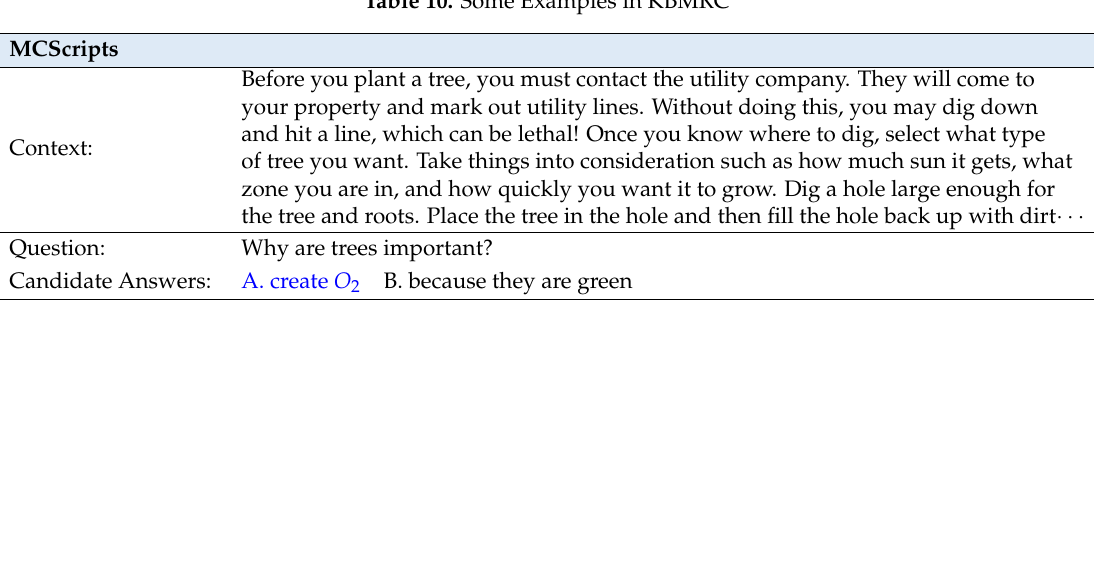
Table 9. Definition of knowledge-based machine reading comprehension.